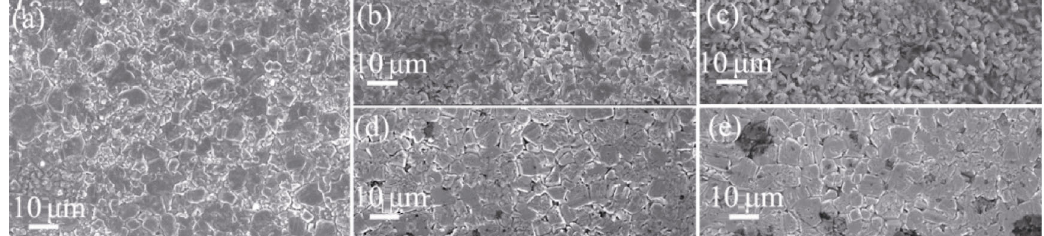
Fig. 16 Microstructural evolution of A2 ceramic during aging after (a) 0 h, (b) 200 h, and (c) 600 h, and thermal shock testing after (d) 30 and (e) 50 cycles.